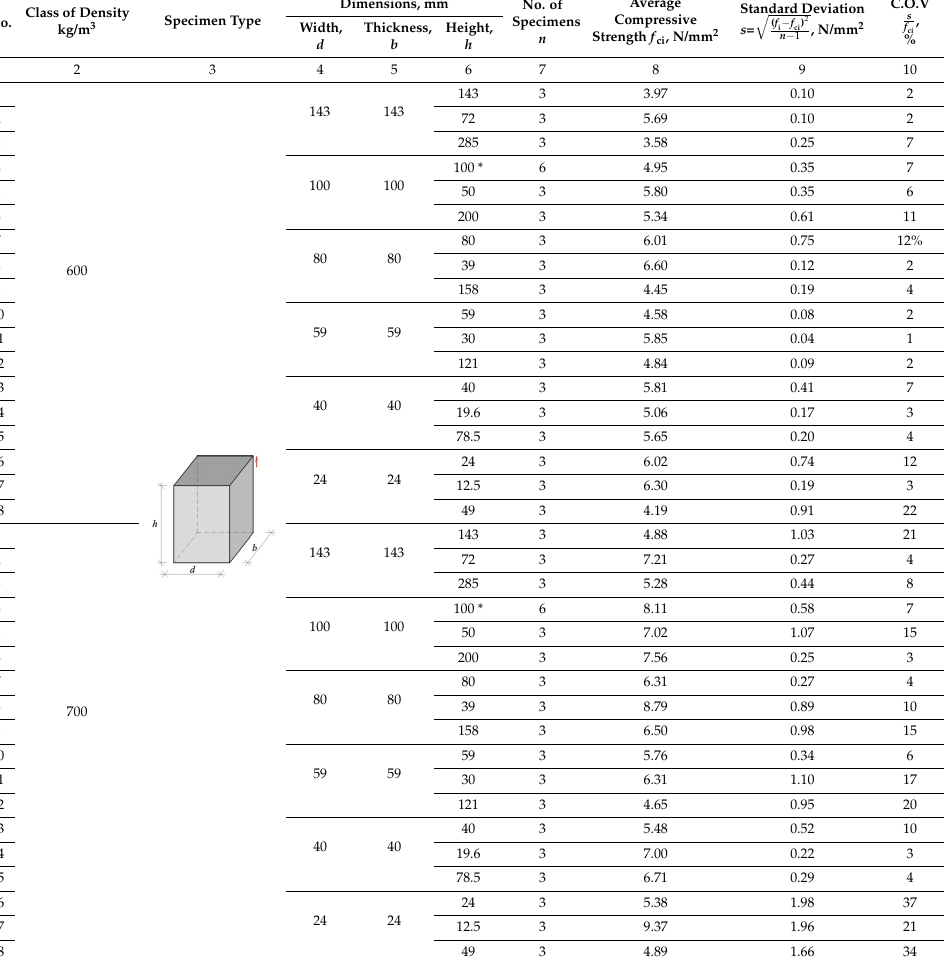
Table 3. Test results for AAC density.